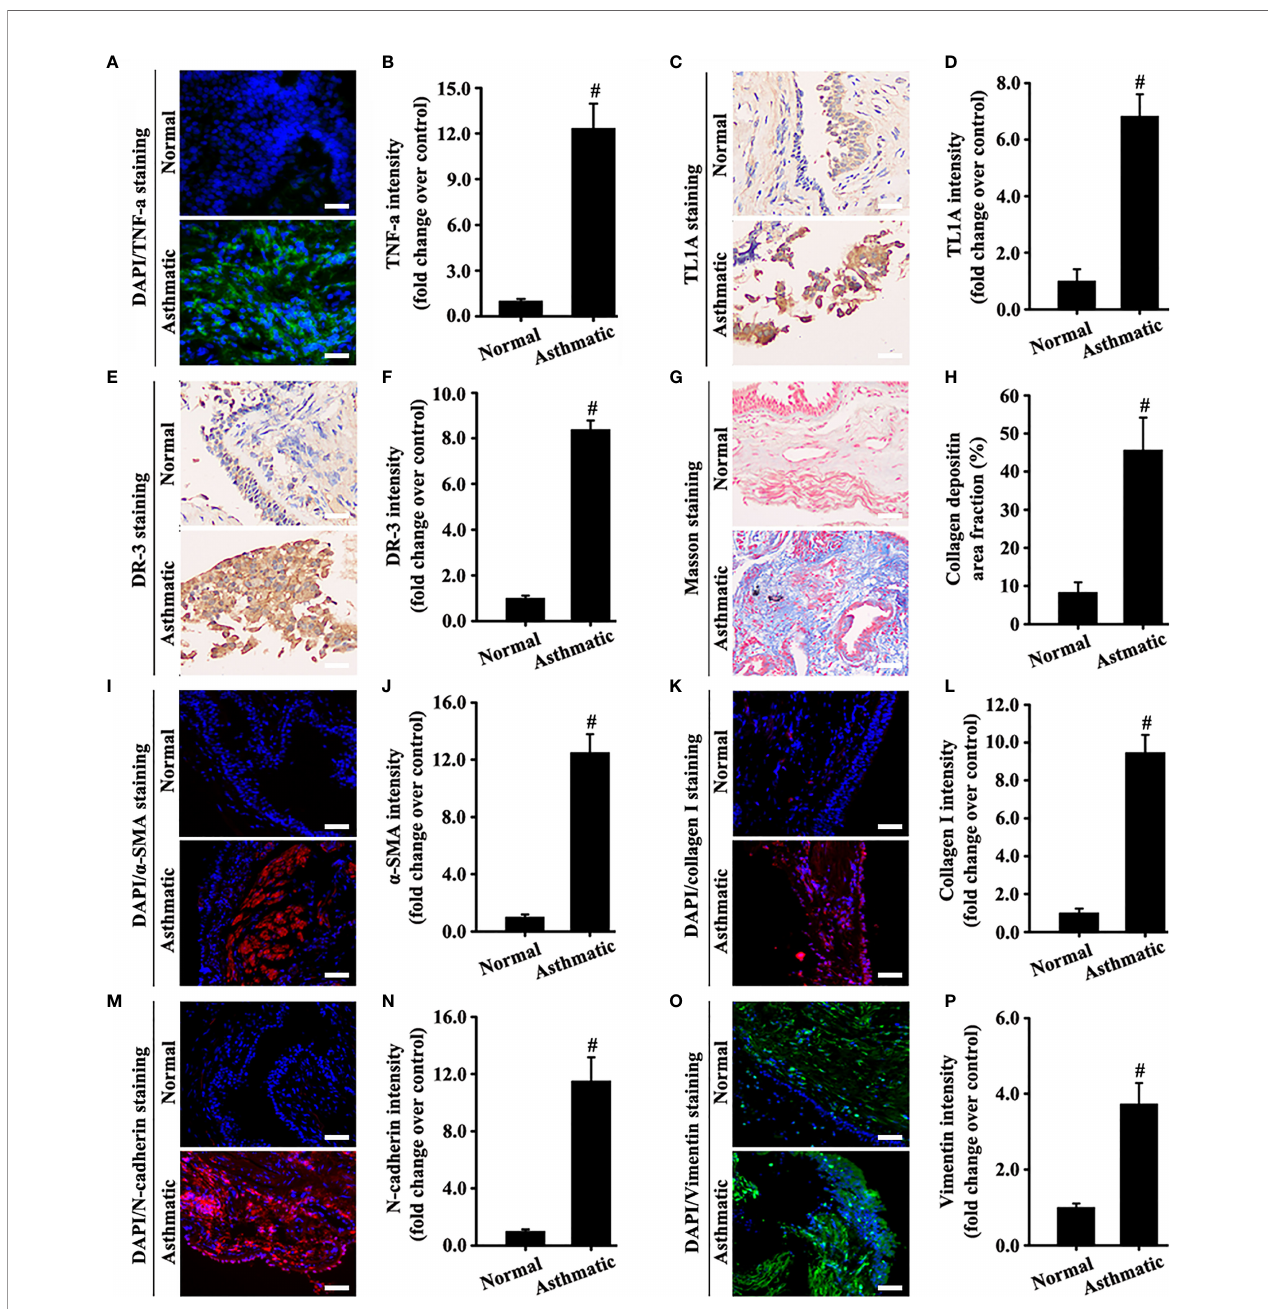
FIGURE 2 | Human bronchial epithelium of asthmatic and normal samples was detected using different experimental techniques. The levels of TNF-a ( A , green), a - SMA ( I , red), collagen I ( K , red), N-cadherin ( M , red), and vimentin ( O , green) were measured by immuno fl uorescence. The levels of TL1A ( C , pale brown) and DR3 ( E , pale brown) were evaluated by immunohistochemistry. Collagen deposition was determined by Masson staining ( G , blue). The blue color (A, I, K, M, O) represents DAPI. (A, C, E, G, I, K, M, O) : magni fi cation 200 ×, scale bar 50 µm. (B, D, F, H, J, L, N, P) intensity analysis of (A, C, E, G, I, K, M, O) . Data are expressed as the means ± SD for three independent experiments. # p < 0.05 versus the normal